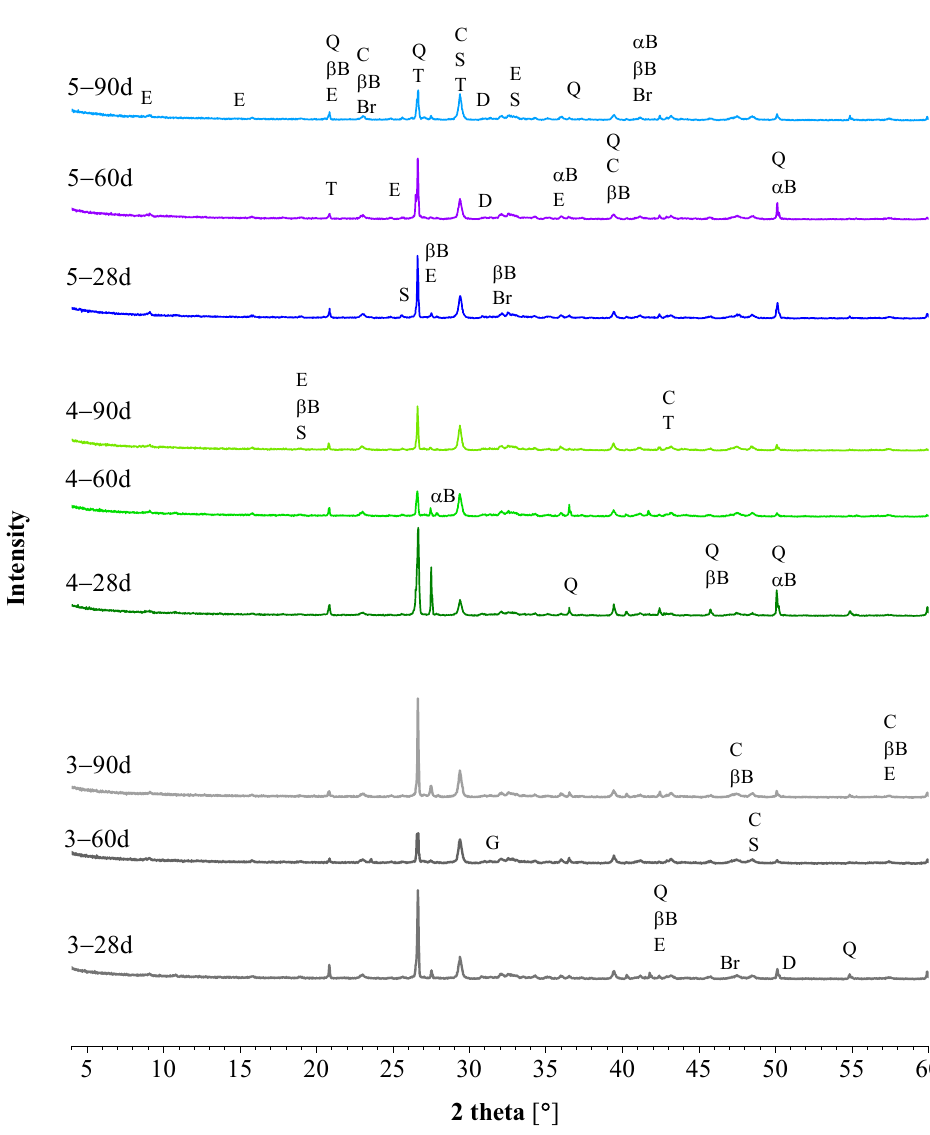
Figure 3. XRD analysis of NCPV mortars: 3_NCPV, 4_NCPV and 5_NCPV (b/a ratio 1:0.5, 1:1 and